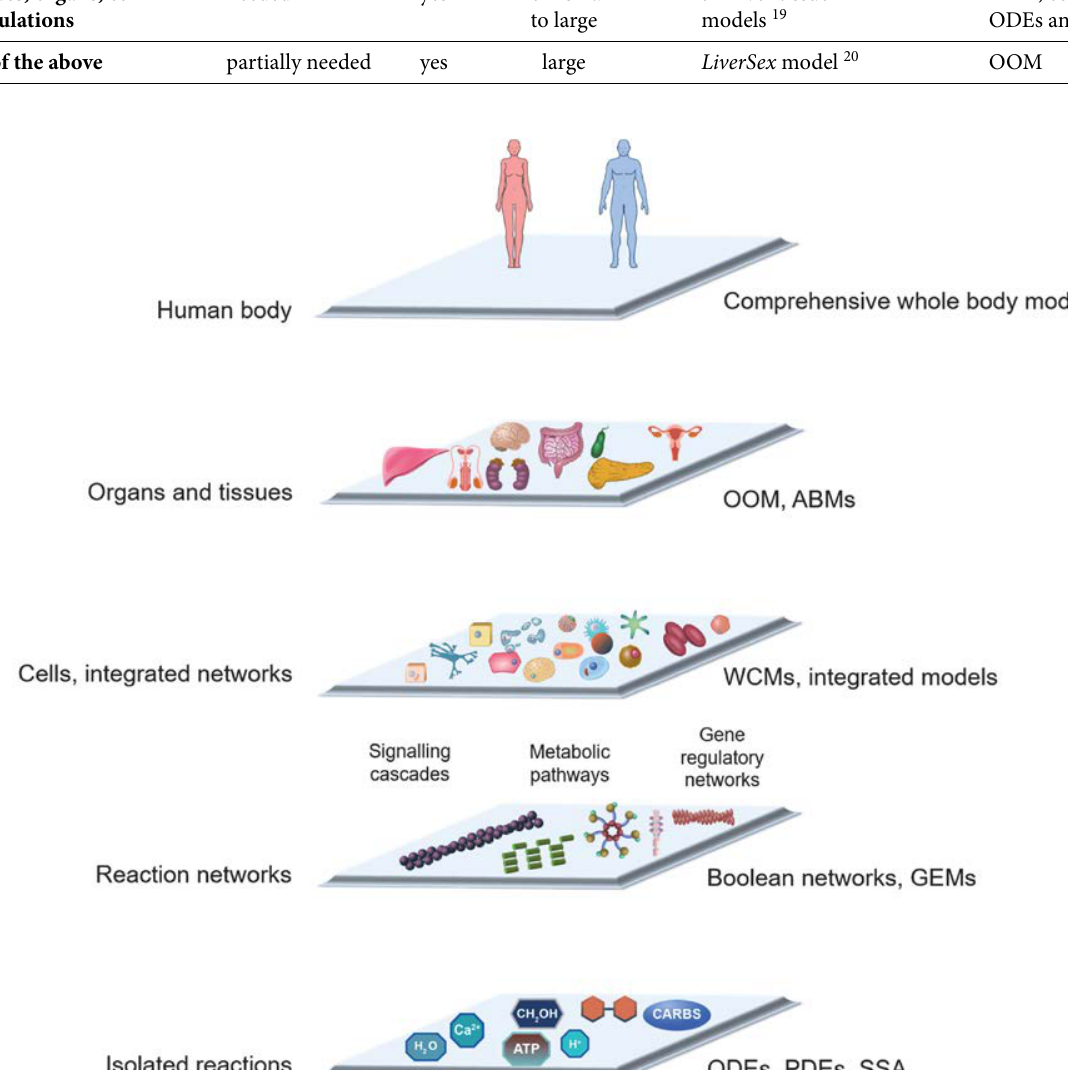
Figure 1: The focus of computational models scales from simple models describing selected chemical reactions to complex models describing reac- tion networks and finally organs and tissues. Abbreviations: ODEs – ordinary differential equations, PDEs – partial differential equations, SSA – stochastic simulation algorithm, GEMs – genome scale metabolic models, WCMs – whole-cell models, ABMs – agent-based models, OOM – ob- ject-oriented